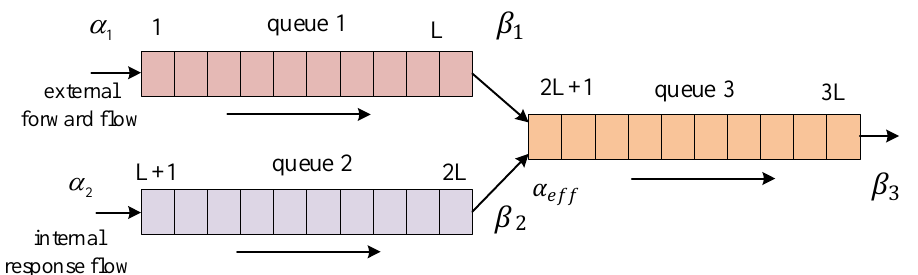
Figure 5. Modeling YELLOW through three TASEP queue with one conjunction.